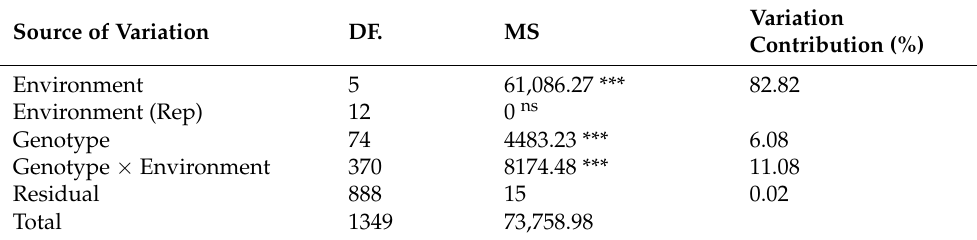
Table 1. Analysis of variance for dry matter yield of 75 QPM genotypes tested in six controlled environments.